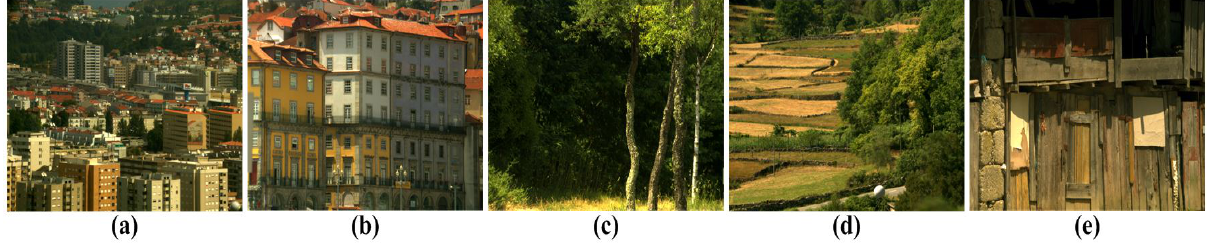
Figure 4. Five multispectral test